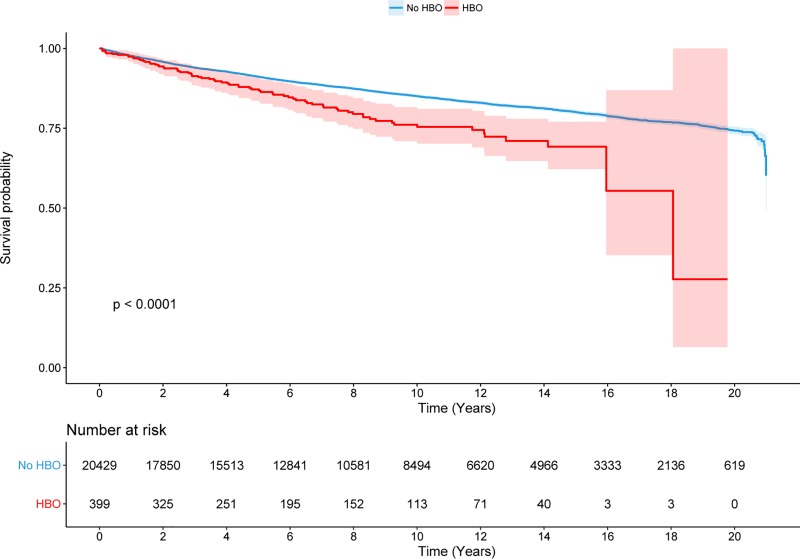
Kaplan-Meier plot of survival depending on treatment.Only those who lived beyond 30 days are included. Light blue-/red-colored areas depicts 95% CI.